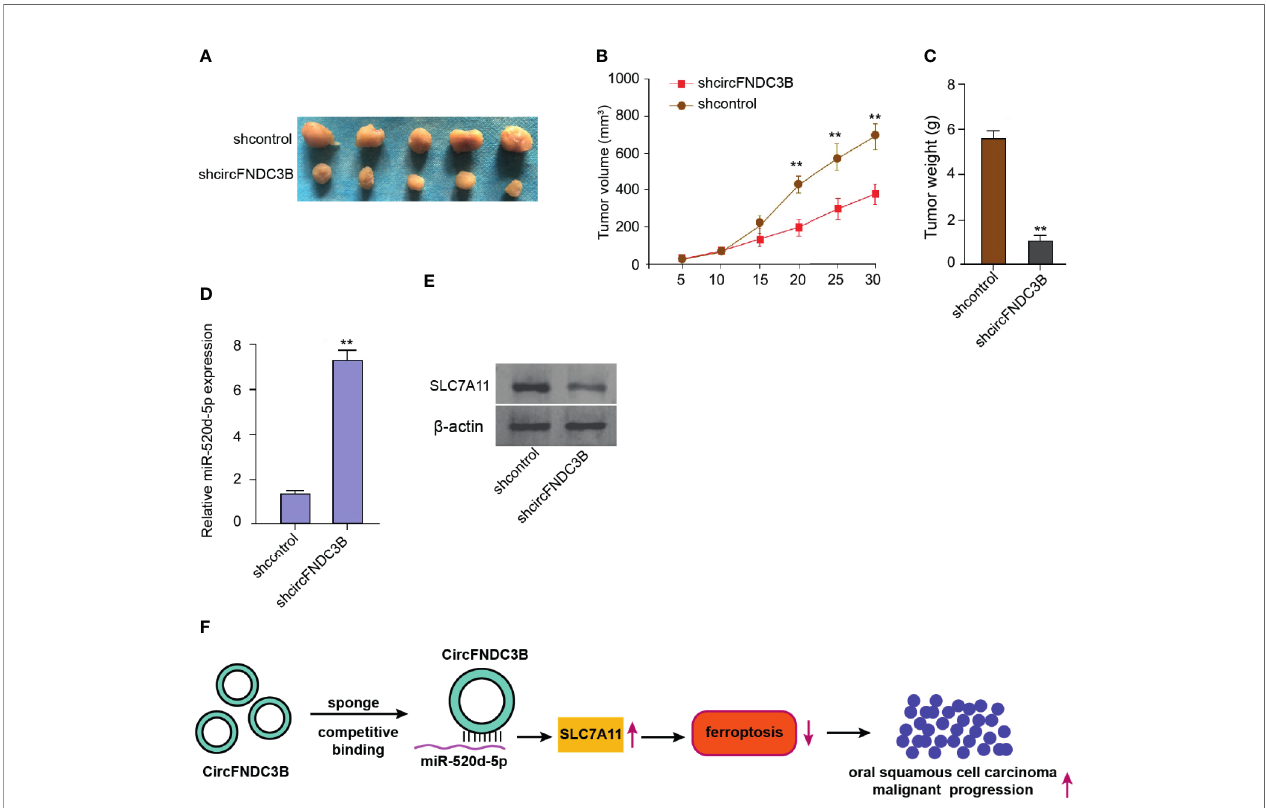
FIGURE 7 | CircFNDC3B contributes to OSCC cells growth in vivo. (A – E) Tumorigenicity assays in nude mice injected with CAL27 cells, which were treated with control shRNA or circFNDC3B shRNA. (A) Representative images of dissected tumors. (B, C) The analysis of average tumor volume and tumor weight. (D) The RT- qPCR assays of miR-520d-5p expression. (E) Western blot analysis of SLC7A11 expression. (F) Schematic diagram of the proposed mechanism of circFNDC3B- mediated ferroptosis and progression of OSCC. N = 5, mean ± SEM: ** P <